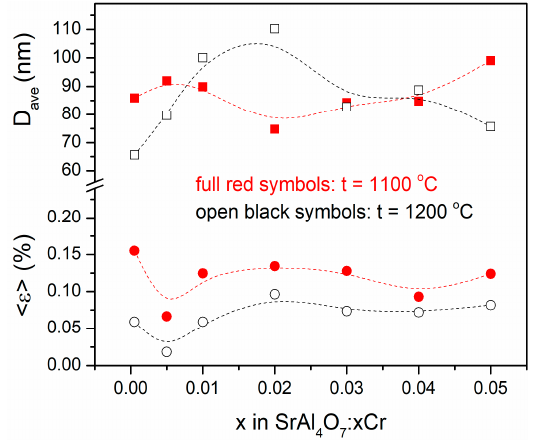
Figure 5. Average crystallite size D ave and lattice strain values < ε > of SrAl 4 O 7 :Cr 3+ powders, depending on the Cr 3+ content and annealing temperature. The dashed B ‐ Spline lines are a visual guide. A full profile Rietveld refinement was also used for the evaluation of precise structural parameters of both SrAl 4 O 7 :Cr 3+ and SrAl 4 O 7 :Mn 4+ series. As the initial model for the refinement of the chromium ‐ and manganese ‐ doped SrAl 4 O 7 ‐ based structures, atomic coordinates in nominally pure SrAl 4 O 7 (CaO ∙ 2Al 2 O 3 ) compound, derived from single ‐ crystal data in Ref. [18] were used. In the refinement procedure, the lattice parameters, coordinates, and displacement parameters of all atoms were refined together with profile parameters and corrections for absorption and instrumental sample shift. In all cases, an excellent agreement between the calculated and experimental diffraction profiles was reached. Exemplary results of the Rietveld refinement of SrAl 4 O 7 :Cr 3+ and SrAl 4 O 7 :Mn 4+ structures are presented in Figure 6.